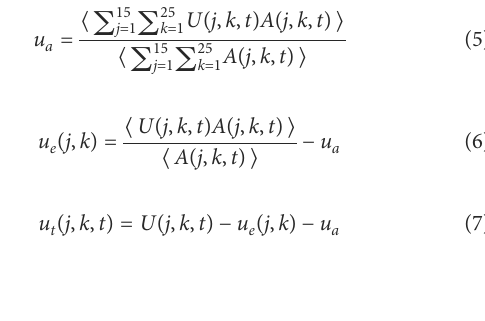
TABLE 2 The ten tidal constituents extracted from the DHI global model (Cheng and Andersen, 2010) at 51.2°E and 28.14°N used in EXP3 and